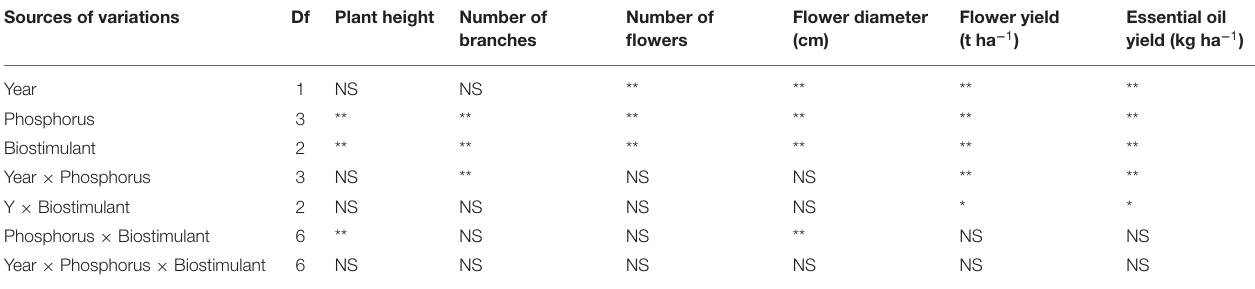
TABLE 1 | Analysis of variance for effect of cropping year, phosphorus and biostimulant on growth and yield traits of M. chamomilla . Sources of variations